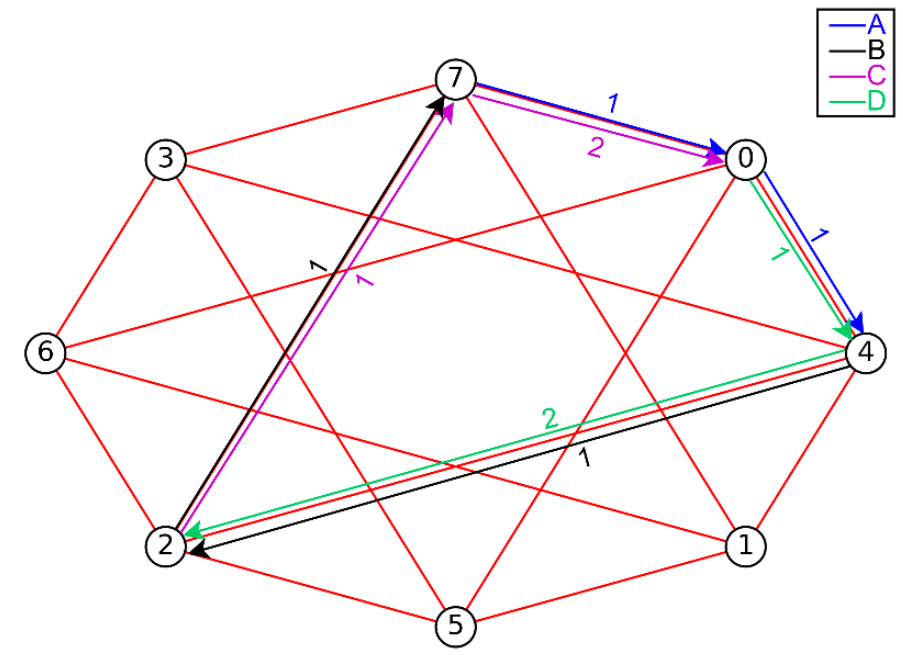
Figure 8. Deadlock-free routing in C 8,4